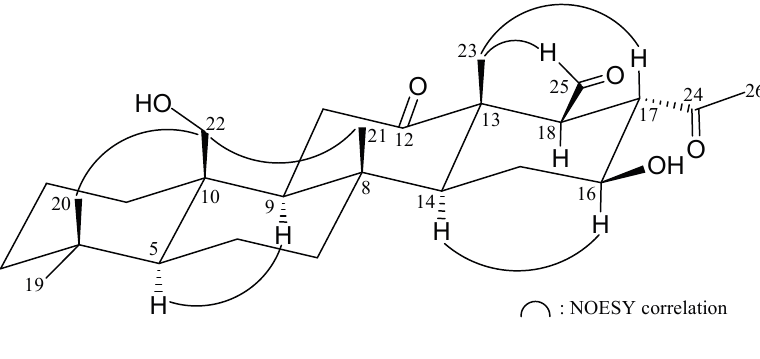
Figure 2. Selective NOESY correlations of 1